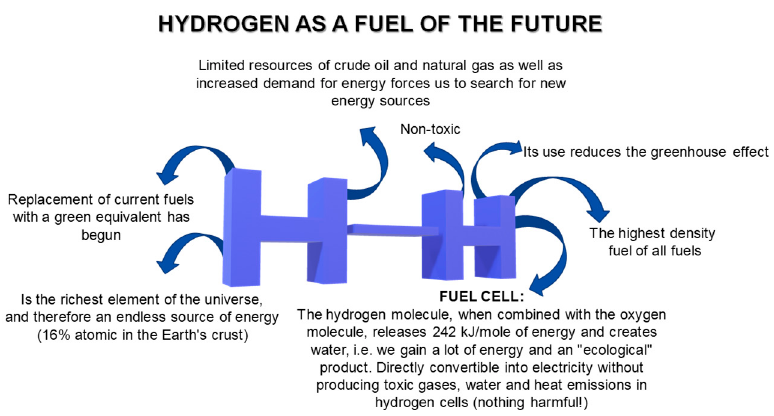
Figure 2. Directions of hydrogen technology.